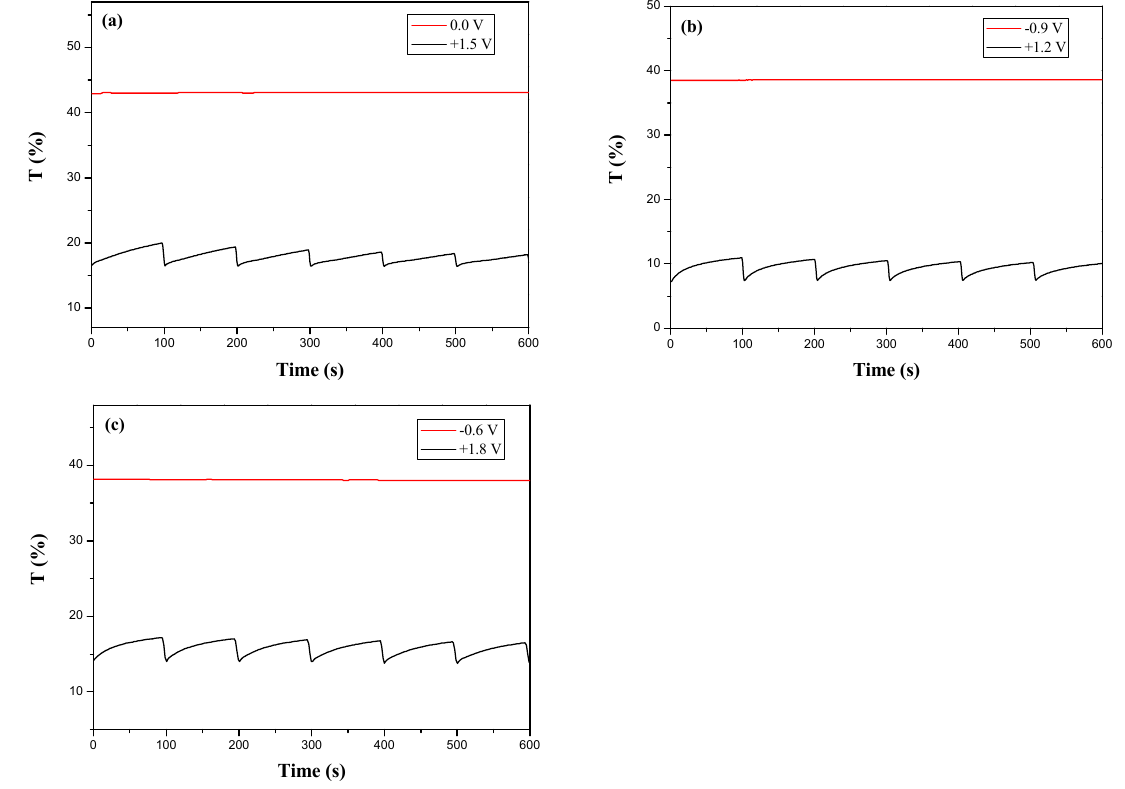
Figure 12. Open circuit stability of ( a ) PInc/PMMA-PC-ACN-LiClO 4 /PEDOT-PSS; ( b ) P(Inc- co -bT)/PMMA-PC-ACN-LiClO 4 /PEDOT-PSS; and ( c ) PbT/PMMA-PC-ACN-LiClO 4 /PEDOT-PSS ECDs.